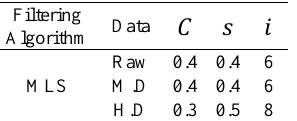
Table 3. The parameters used in the ETEW algorithm (M.D stands for medium-density and H.D means high-density) Table 4 shows the optimum parameters used in the ATIN algorithm. Experiments indicated that the cell size, Z difference and initial grid size parameters effect the performance of this algorithm most. The parameters used in the ATIN algorithm are as follows; Cell size ( 𝐶 ) is the size of each grid and is used to divide the point cloud into grids. Z difference ( 𝑍𝑑 ) is the threshold for the elevation difference between each point and triangular surface (Zhang and Cui, 2007). Initial grid size ( 𝐼𝐺 ) parameter